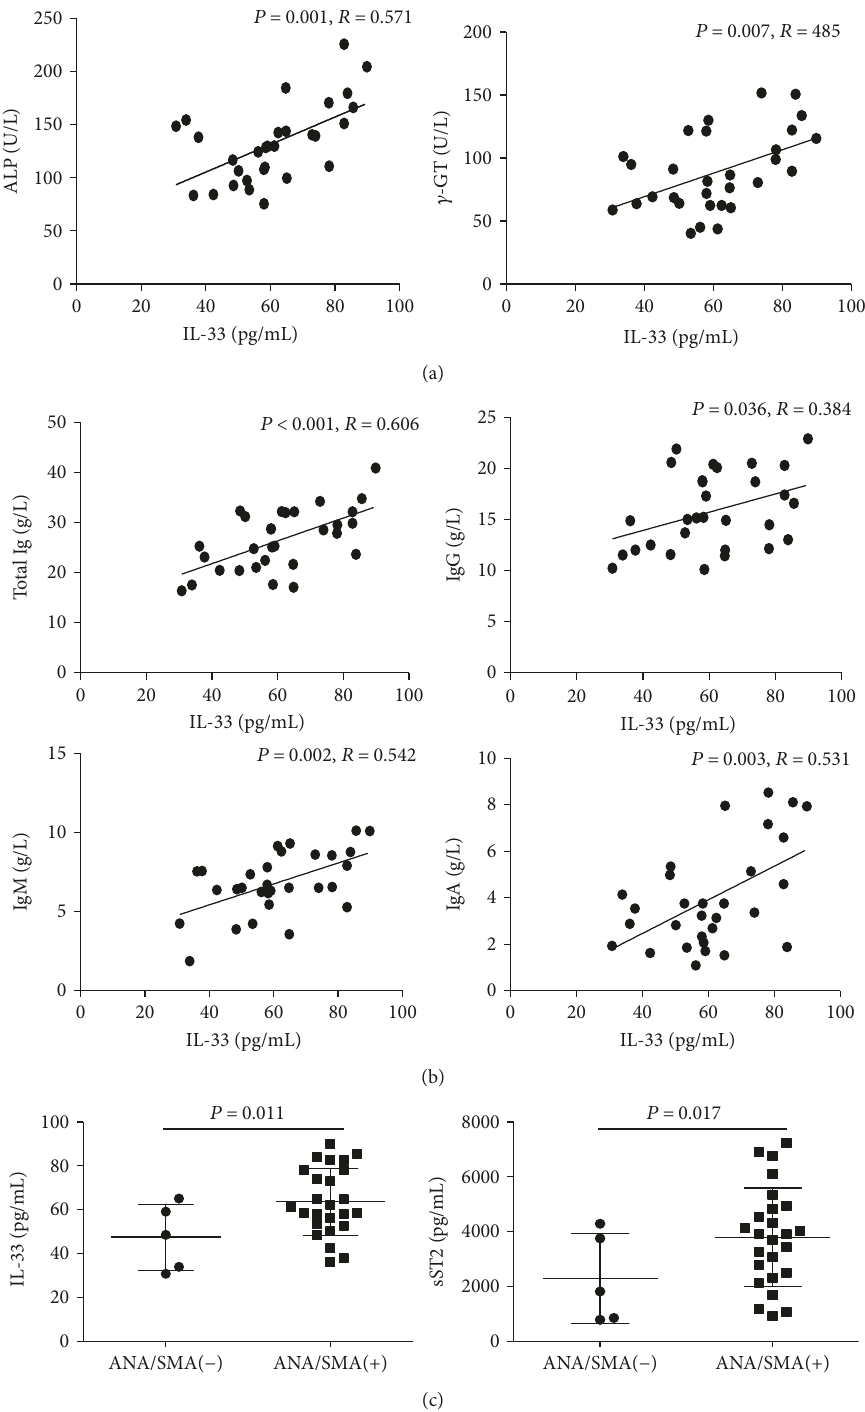
Figure 3: Correlation between serum levels of IL-33 and the values of clinical parameters in AIH patients. Correlation between serum levels of (a) IL-33 and ALP/ γ -GGT; (b) IL-33 and total Ig (sum of IgA/IgG/IgM titers), IgG, IgM, and IgA in AIH patients; (c) IL-33/sST2 in the seropositive (25 cases) and seronegative (5 cases) anti-ANA/SMA AIH patients. The horizontal lines indicate the mean values for the di ff erent